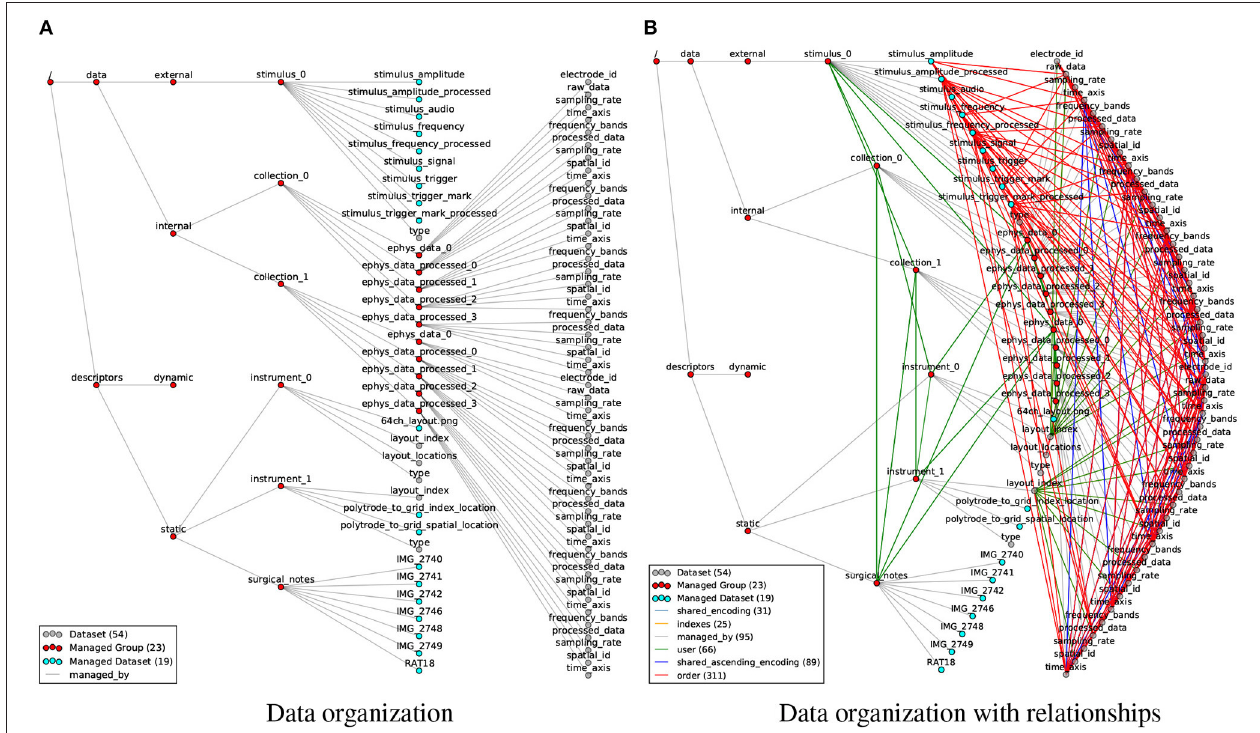
FIGURE 6 | (A) Visualization of the organization of datasets and groups in the rat electrophysiology recordings using our data format, with gray edges ( managed by ) indicating the hierarchy of objects in the HDF5 file. (B) Same as (A) but additionally showing all 522 relationship attributes (colored edges) describing structural and semantic relationships between the data objects. The number of nodes and edges in the graph are indicated in the legend. In addition, the file also contains 372 regular attributes (not shown).